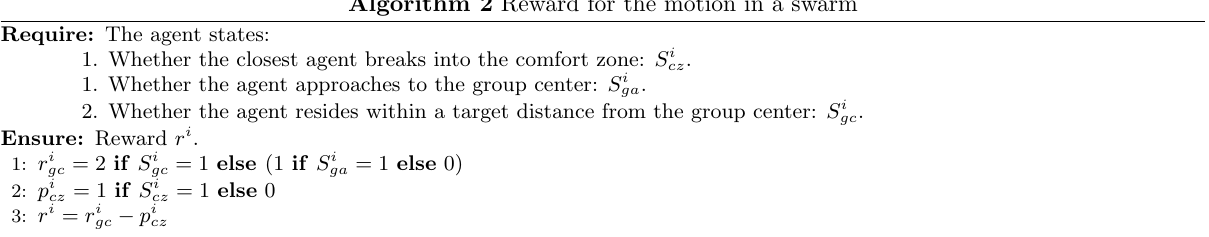
Algorithm 2 Reward for the motion in a swarm